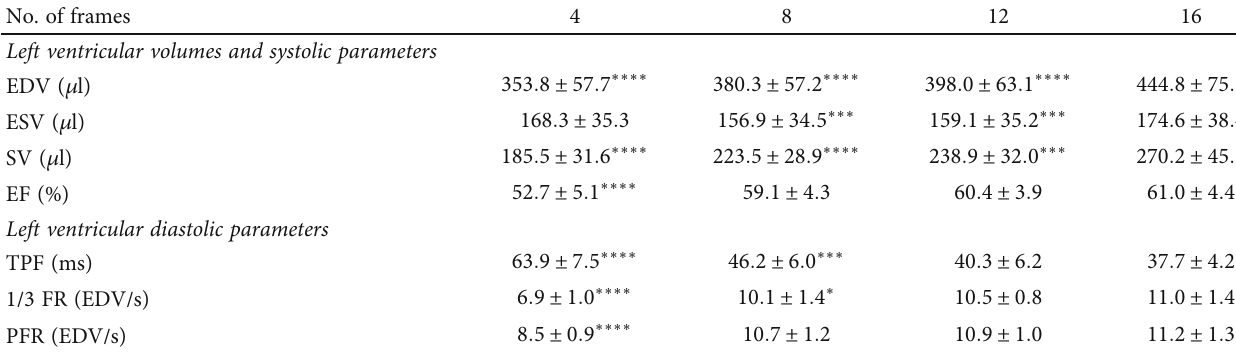
Table 1: Comparison of the LV functional parameters between the di ff erent gated reconstructions of all rats ( n = 12 ). No. of